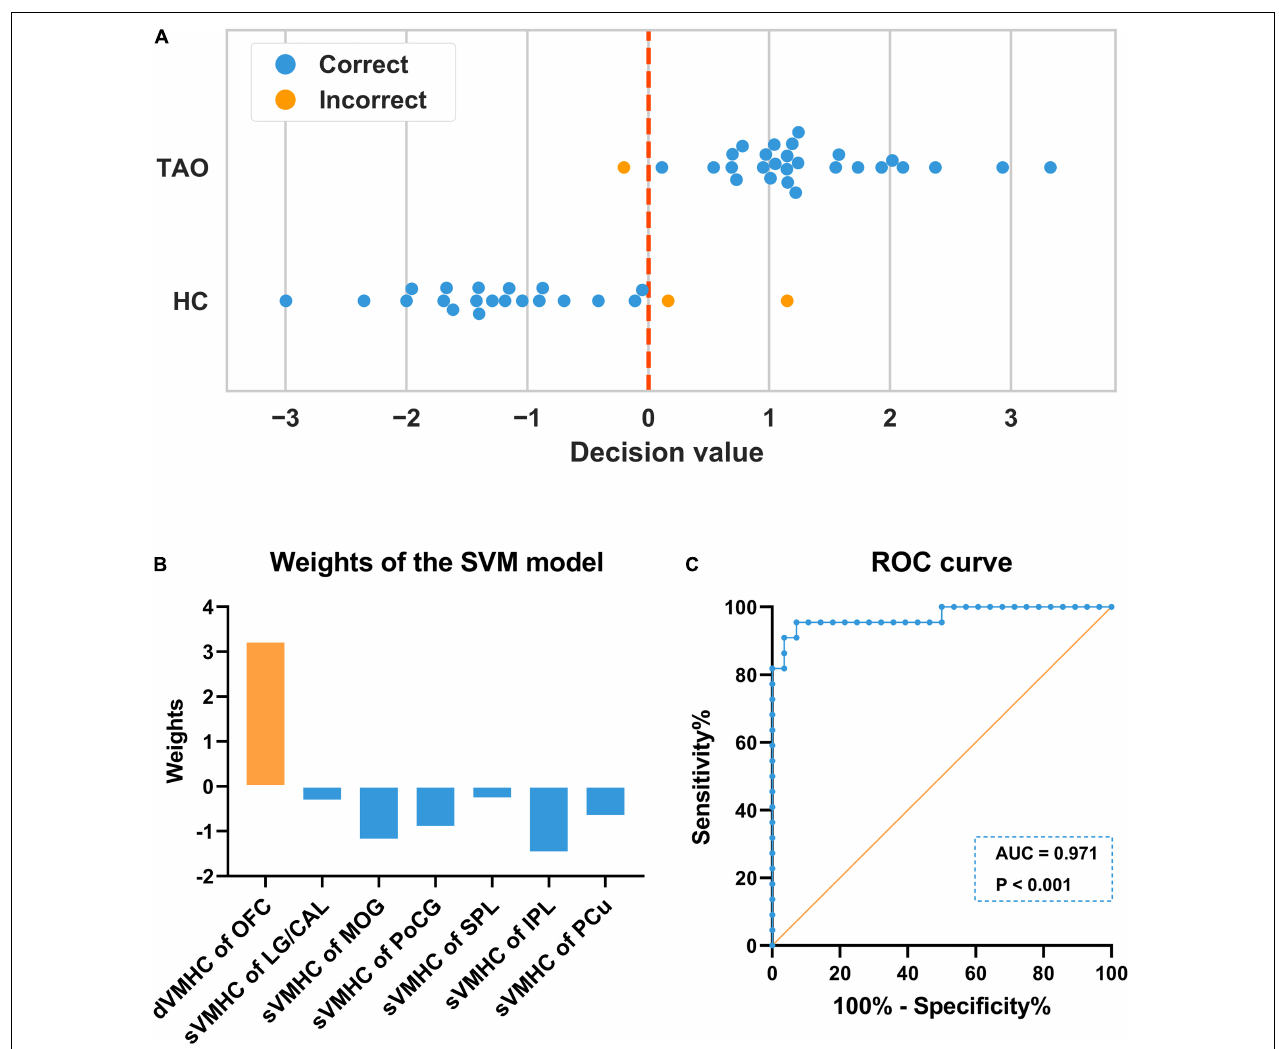
FIGURE 4 | Illustration of the SVM classification results. (A) In each LOOCV, one subject’s data was left out as the testing sample, whose class label was then predicted with the training model based on the remaining subjects’ data. The predicted label would be 1 (TAO) if the decision value was positive, while –1 (HC) if the decision value was negative. The blue color denotes the sample was correctly classified, whilst the orange color denotes the sample was incorrectly classified. The final accuracy was 94% (47/50). (B) In the SVM model, dynamic VMHC of OFC exhibited higher weight than others in classifying the two groups. (C) The ROC curve showed that the model had good performance to distinguish TAOs from HCs, with an AUC of 0.971 ( P < 0.001). SVM, support vector machine; LOOCV, “leave-one-out” cross-validation; TAO, thyroid-associated ophthalmopathy; HC, healthy control; VMHC, voxel-mirrored homotopic connectivity; dVMHC, dynamic VMHC; sVMHC, static VMHC; OFC, orbitofrontal cortex; LG, lingual gyrus; CAL, calcarine; MOG, middle occipital gyrus; PoCG, postcentral gyrus; SPL, superior parietal lobule; IPL, inferior parietal lobule; PCu, precuneus; ROC, receiver operating characteristic; AUC, area under the